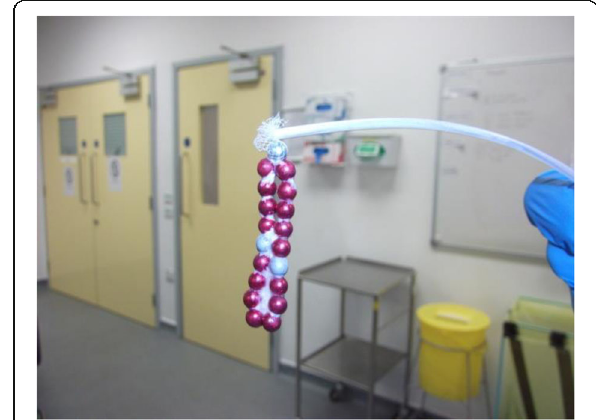
Fig. 6 Demonstration of the strong force upon which the basic magnetic retriever attaches to the ingested